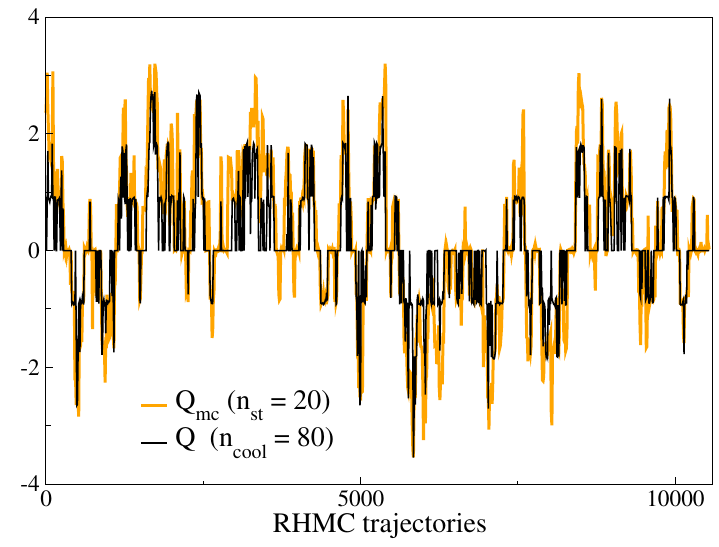
Figure 5 . Monte-Carlo history of the topological charges obtained after 80 cooling steps and after 20 stout-smearing steps (with (cid:26) st = 0 : 1), for the run on the 32 3 (cid:2) 8 lattice at (cid:12) = 4 : 14, adopting a bias potential as in eq. (2.12), with B = 6 and C = 2, and illustrated in (cid:12)gure